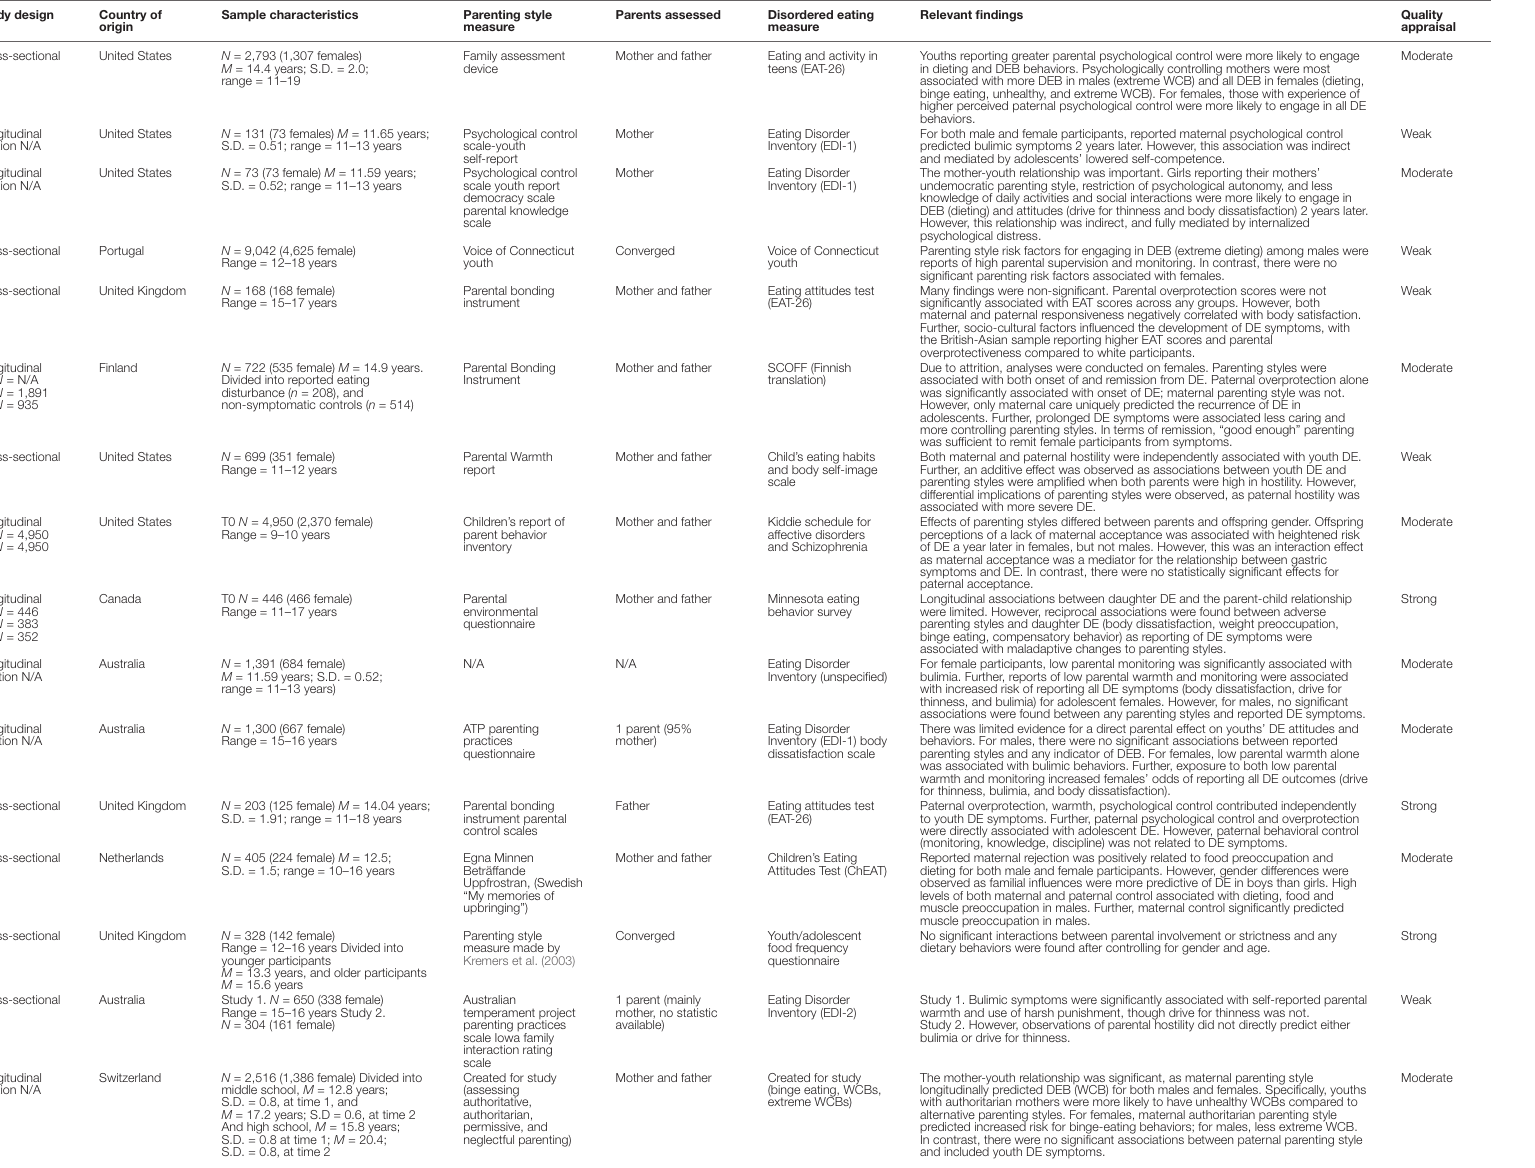
TABLE 1 | Characteristics of cross-sectional and longitudinal studies analyzing the effect of parenting styles on youth presentation of disordered